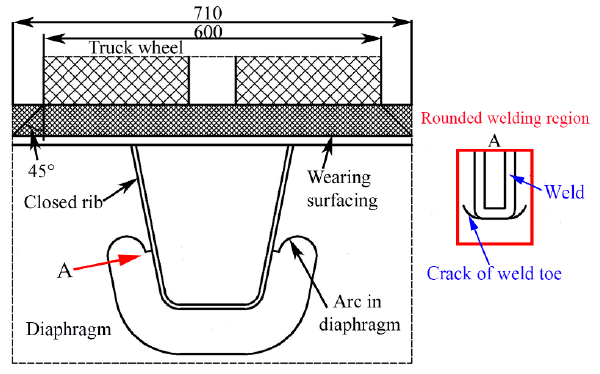
Figure 1. Fatigue crack of the rounded welding region between a closed rib and a diaphragm (in mm).